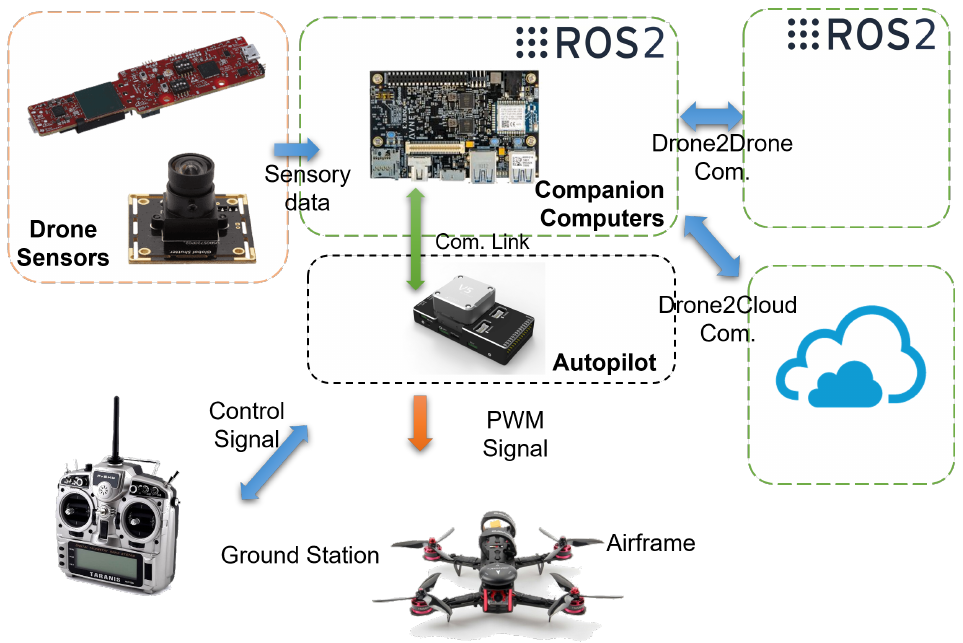
Figure 3. Drone hardware/software architecture.